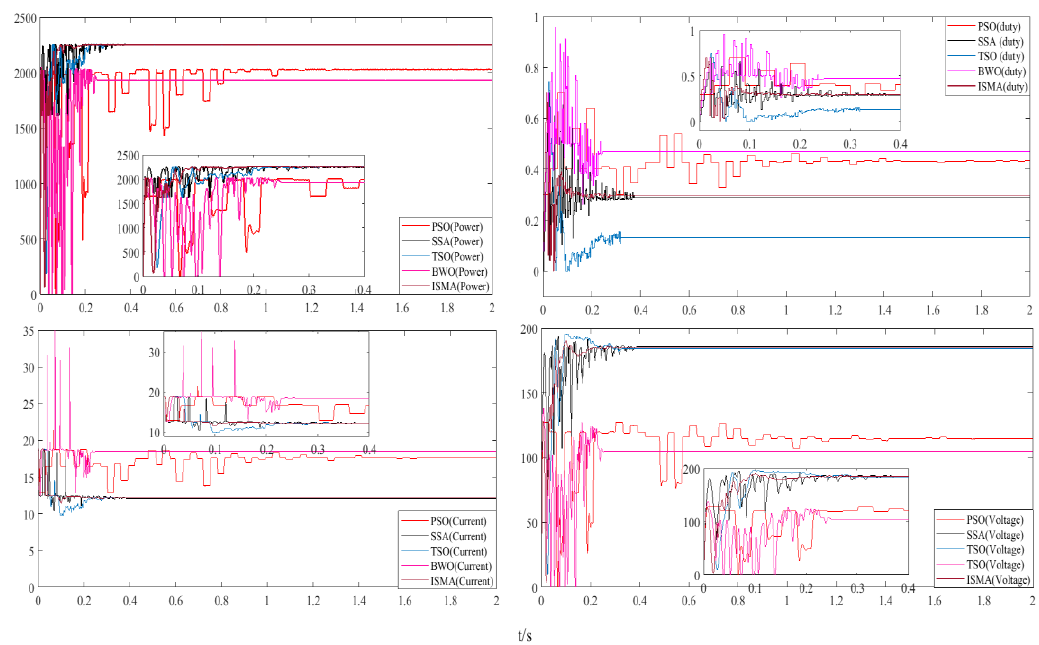
Figure 10. Output curves of five different algorithms under PSC3 conditions.